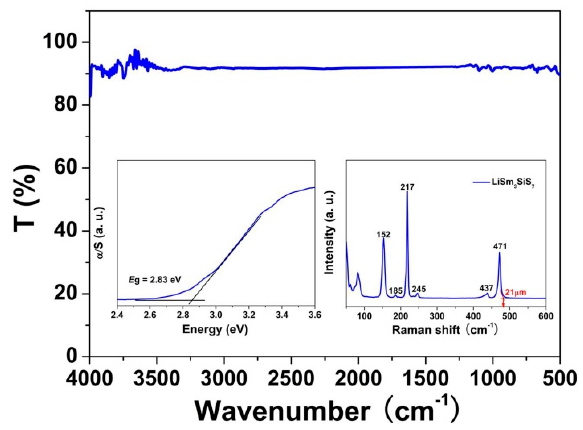
Figure 2. Optical properties (infrared (IR), bandgap, and Raman) of LiSm 3 SiS 7 . Table 2. Laser-damage thresholds (LDTs) of LiSm 3 SiS 7 and AgGaS 2 (as the reference).